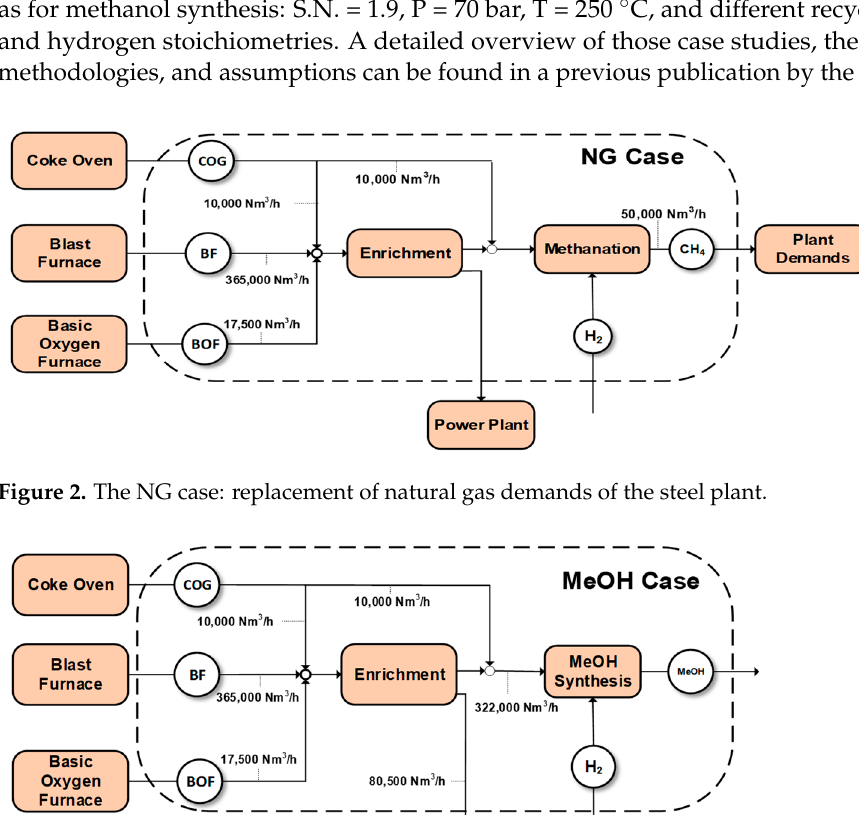
Figure 3. The MeOH case: methanol synthesis of 80% of the available off-gases.